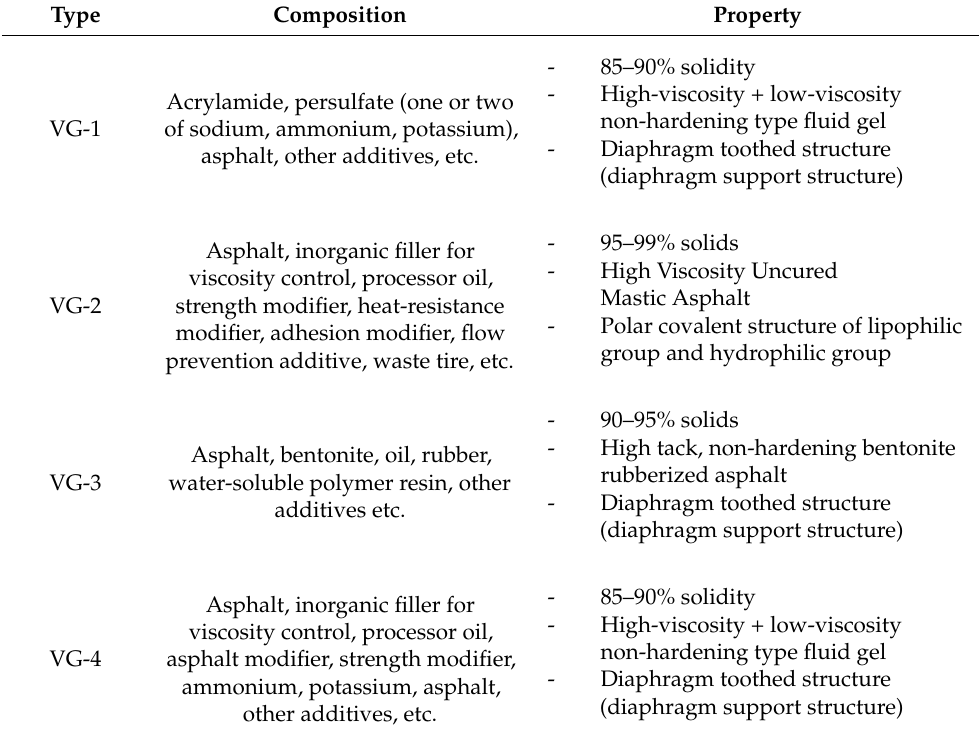
Table 1. The composition and properties of NHV-SPRG composite waterproofing sheets of 4 types.